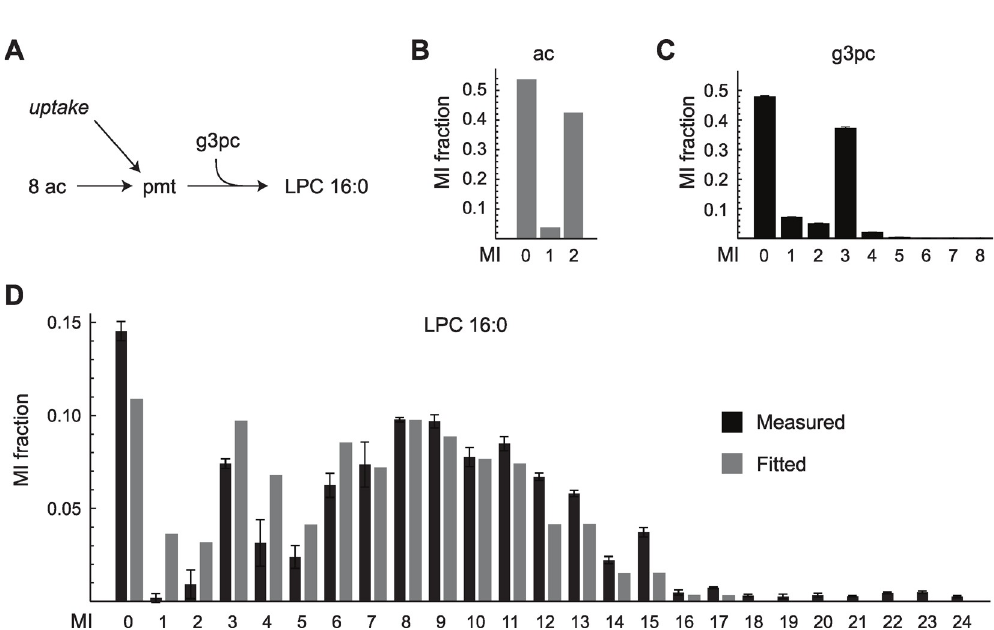
Fig 13. Validation of lipid synthesis in HMEC cultures. (A) Schematic of the model for lysophosphatidylcholine (LPC) 16:0 synthesis from acetate (ac). (B) Predicted MID of ac from the model selected by the “Validation” method. (C) Measured MID of glycerol-3-phosphocholine (g3pc). (D) Fitted (gray) and measured (black) MID of LPC 16:0. Mean values of biological triplicates are shown in (C, D). Error bars indicate standard deviation.